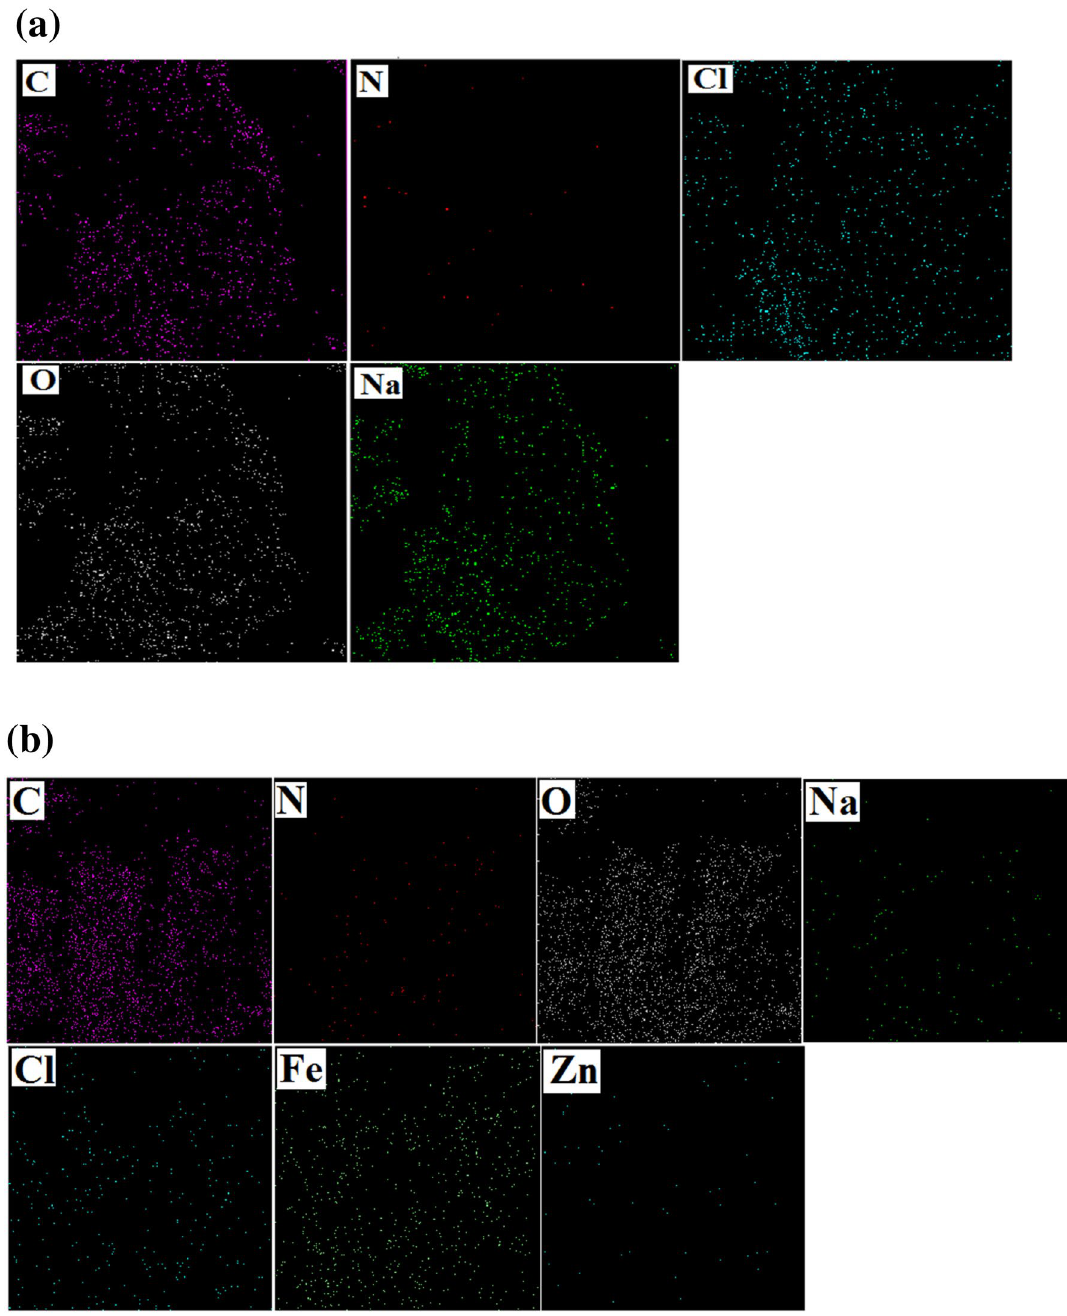
Figure 5. Maps of ( a ) raw lignocellulosic sawdust and ( b ) lignocellulosic sawdust-Fe/Zn